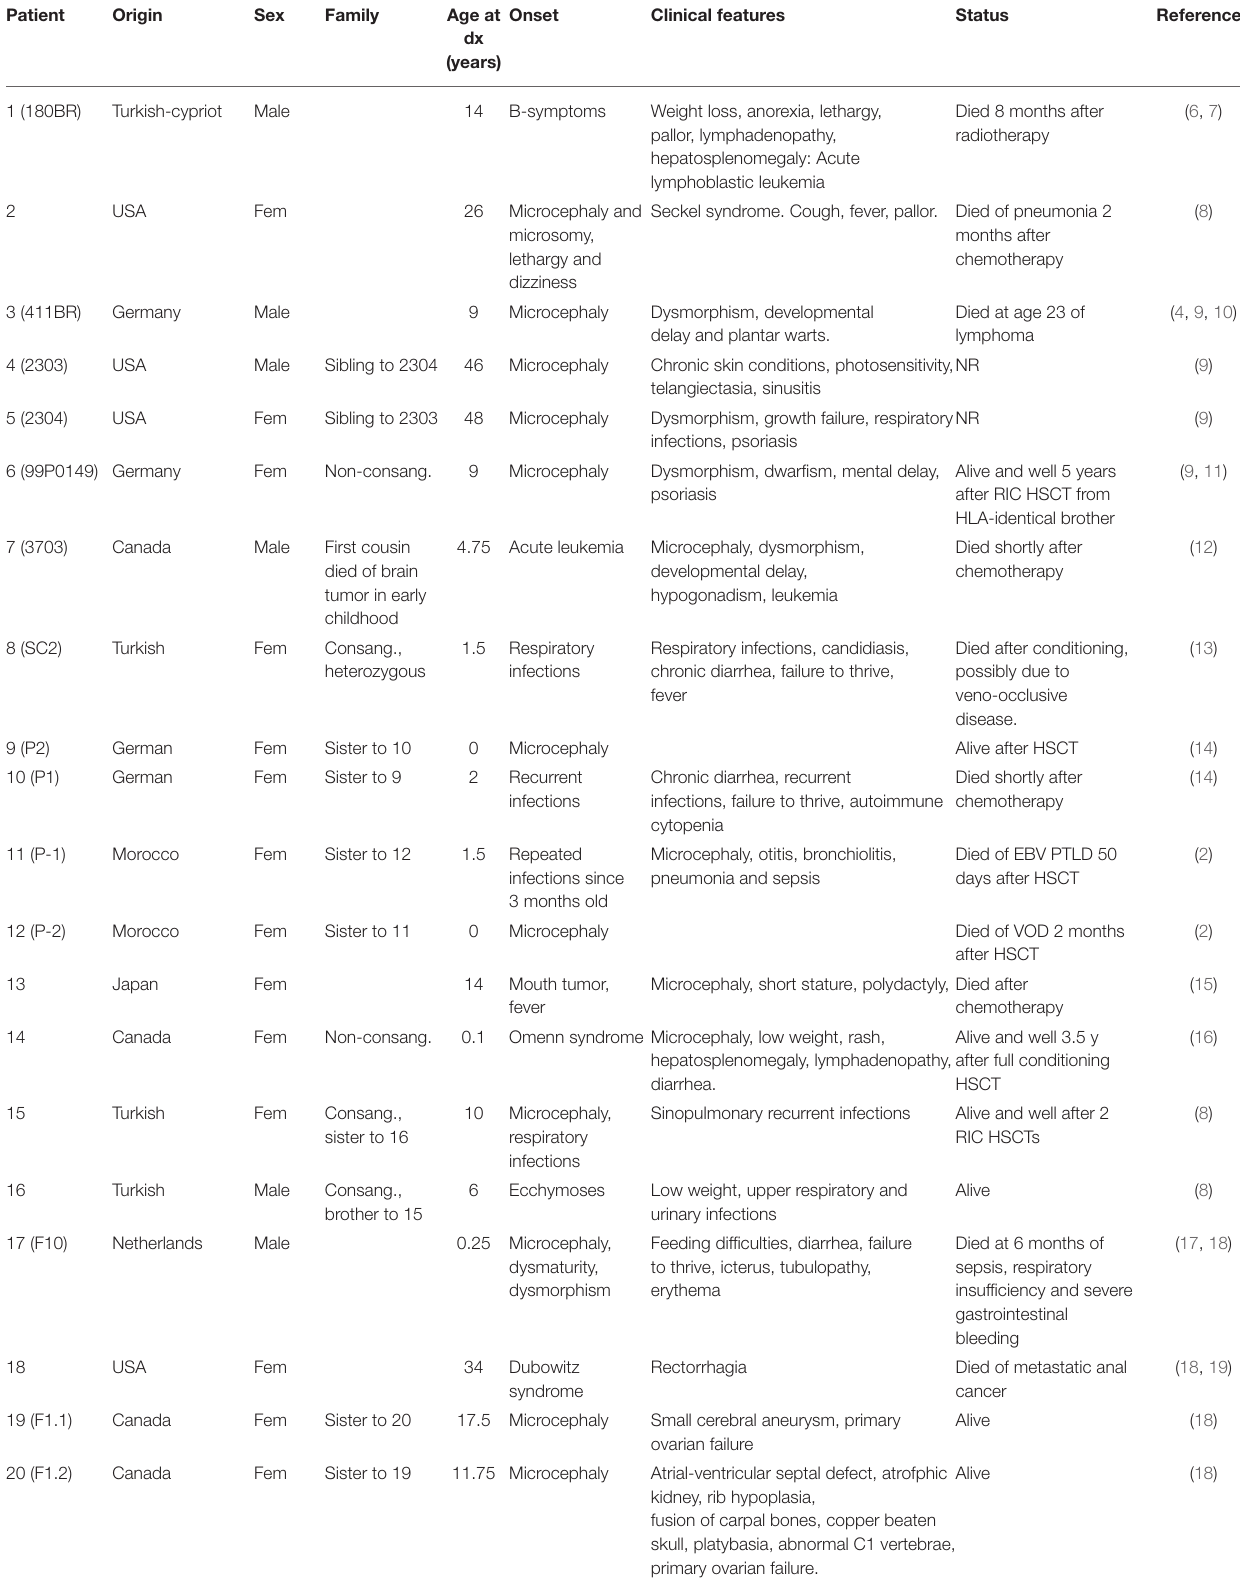
TABLE 1 | Demographic and clinical features of published patients with LIG4 deficiency.